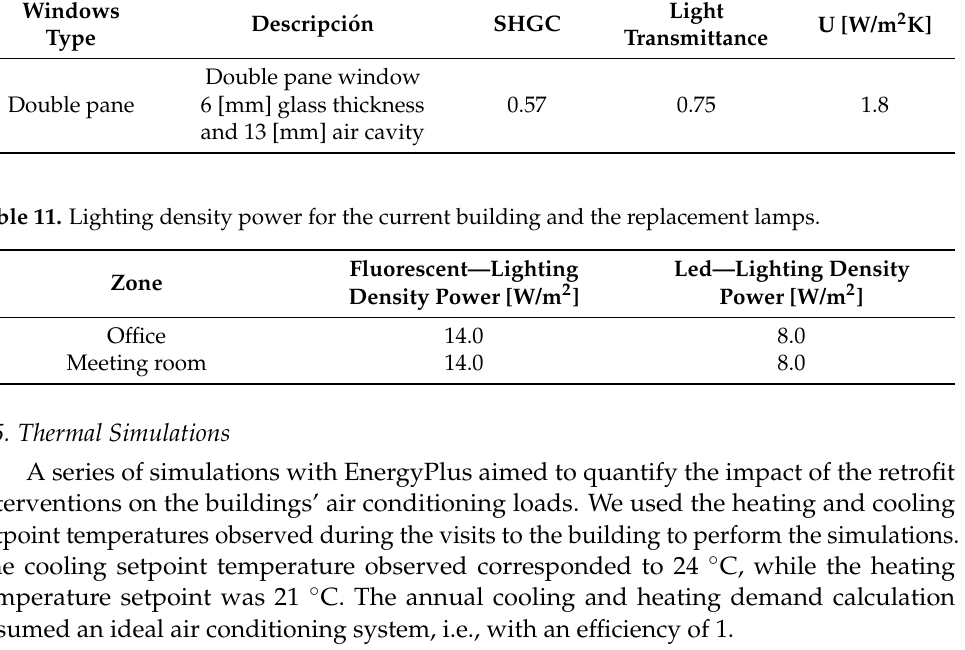
Figure 4. Rendered view of south façade; with ( right ) and without ( left ) solar control for the summer design day (Time: 16:30 h). Table 10. Properties of the Low-E windows.